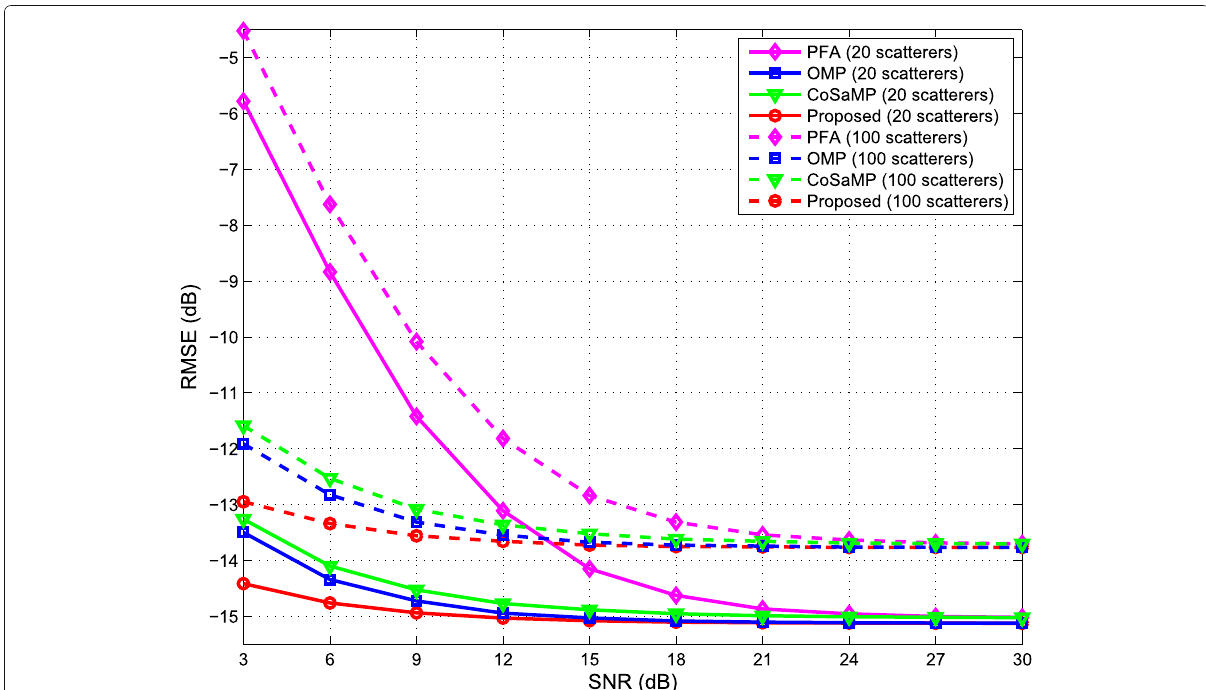
Fig. 7 RMSE comparison for different number of scatterers versus SNRs, by 500 Monte-Carlo trials